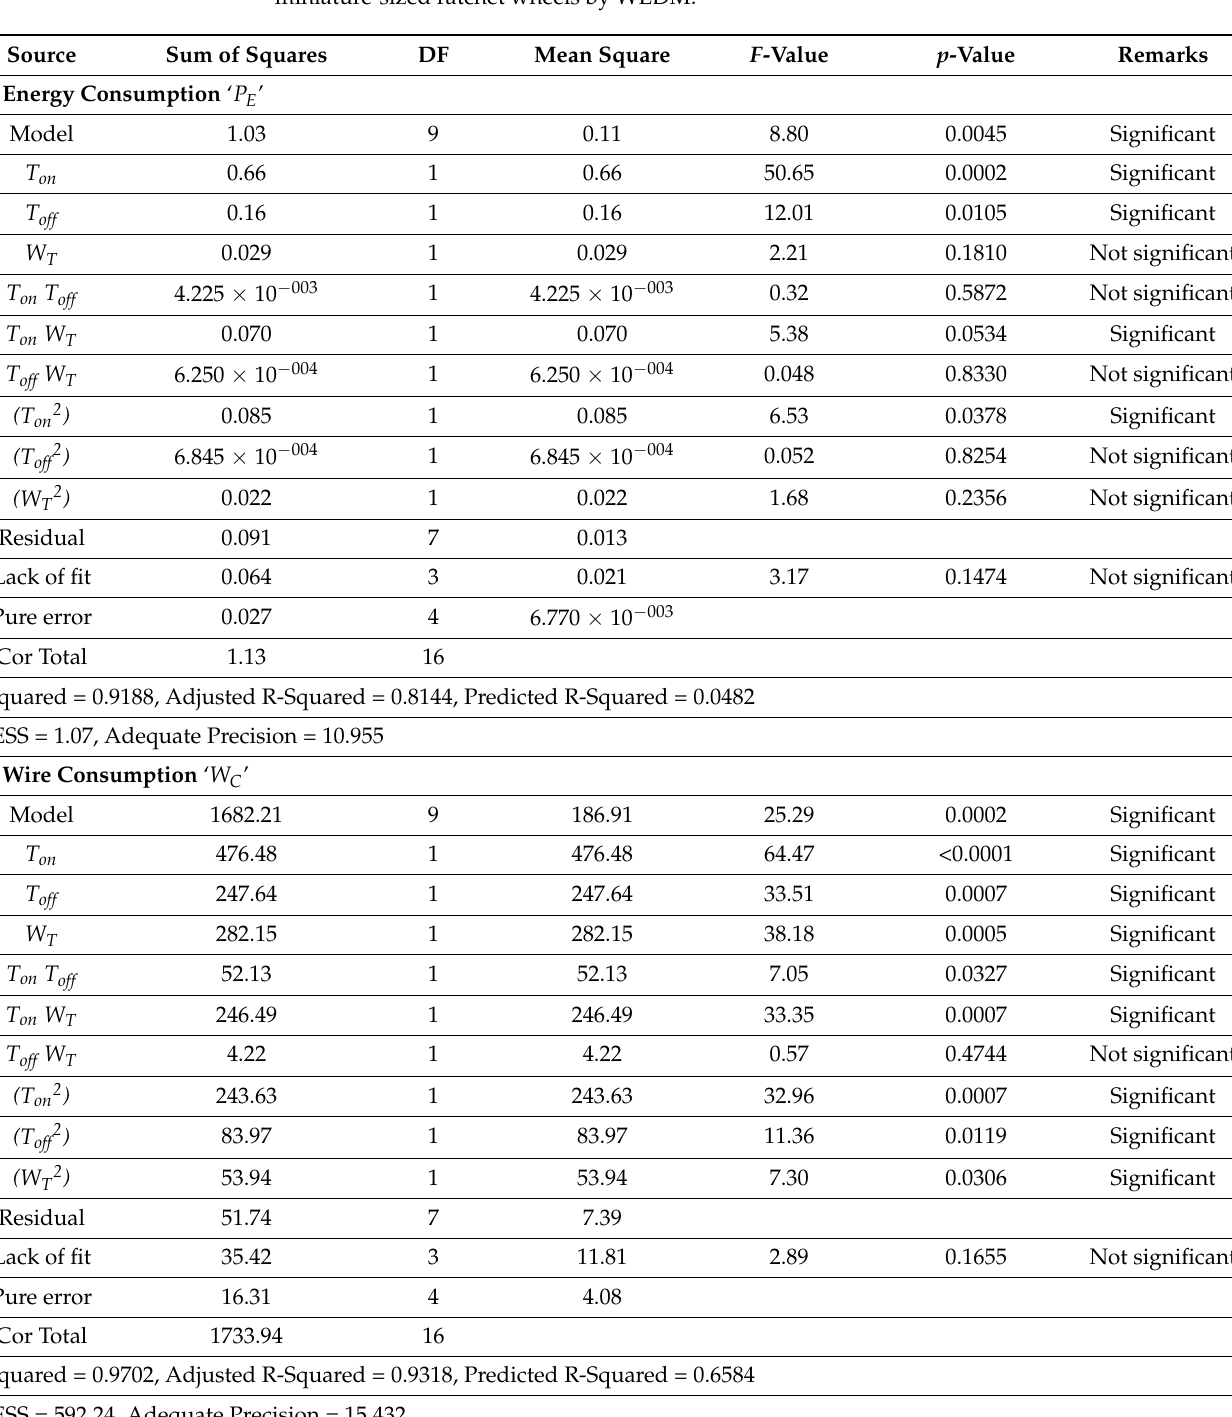
Table A1. Results of ANOVA for energy and wire consumption during the manufacturing of miniature-sized ratchet wheels by